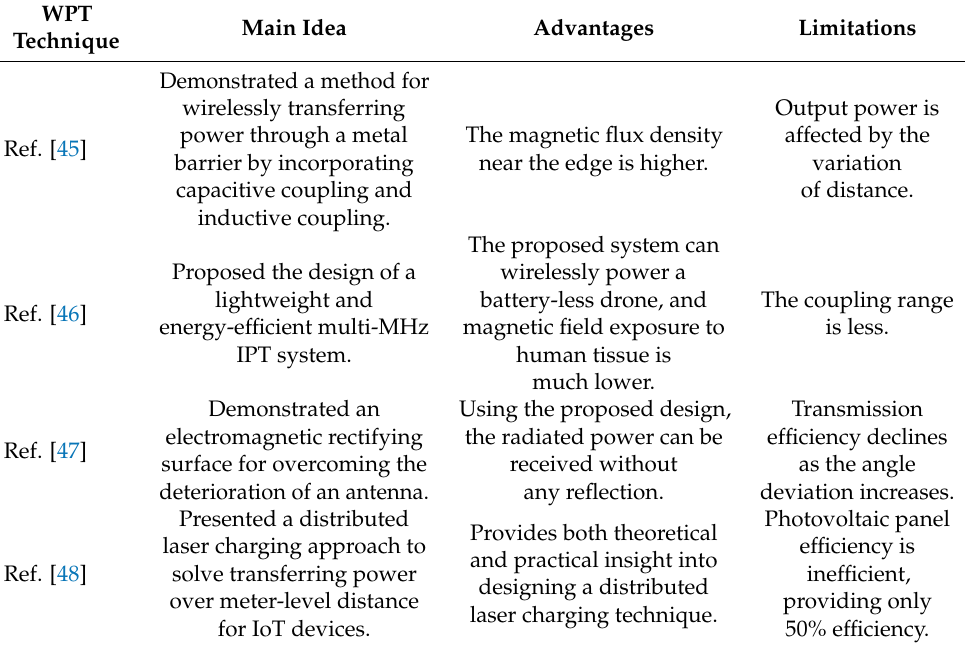
Table 5. Comparison of existing WPT Technologies in terms of the main idea, advantages, and limita- tions.